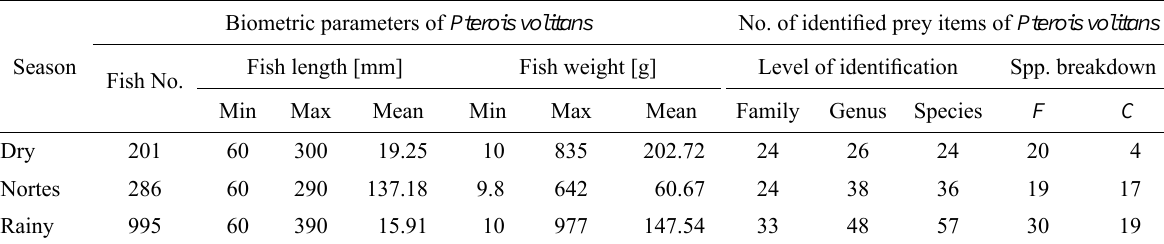
F = number of prey species representing fi shes, C = number of prey species representing crustaceans; Nortes season = October–January.